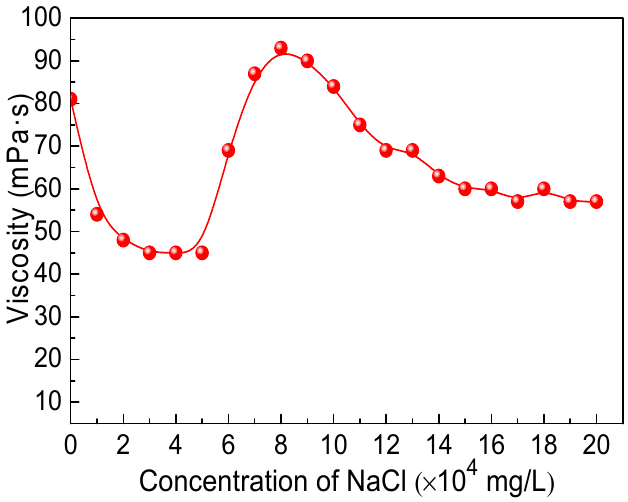
Figure 9. Effect of NaCl concentration on viscosity of a 0.3 wt% DiPHAM aqueous solution. The varied aggregations of DiPHAM (500 mg/L) molecules in different NaCl concentrations (4 ×